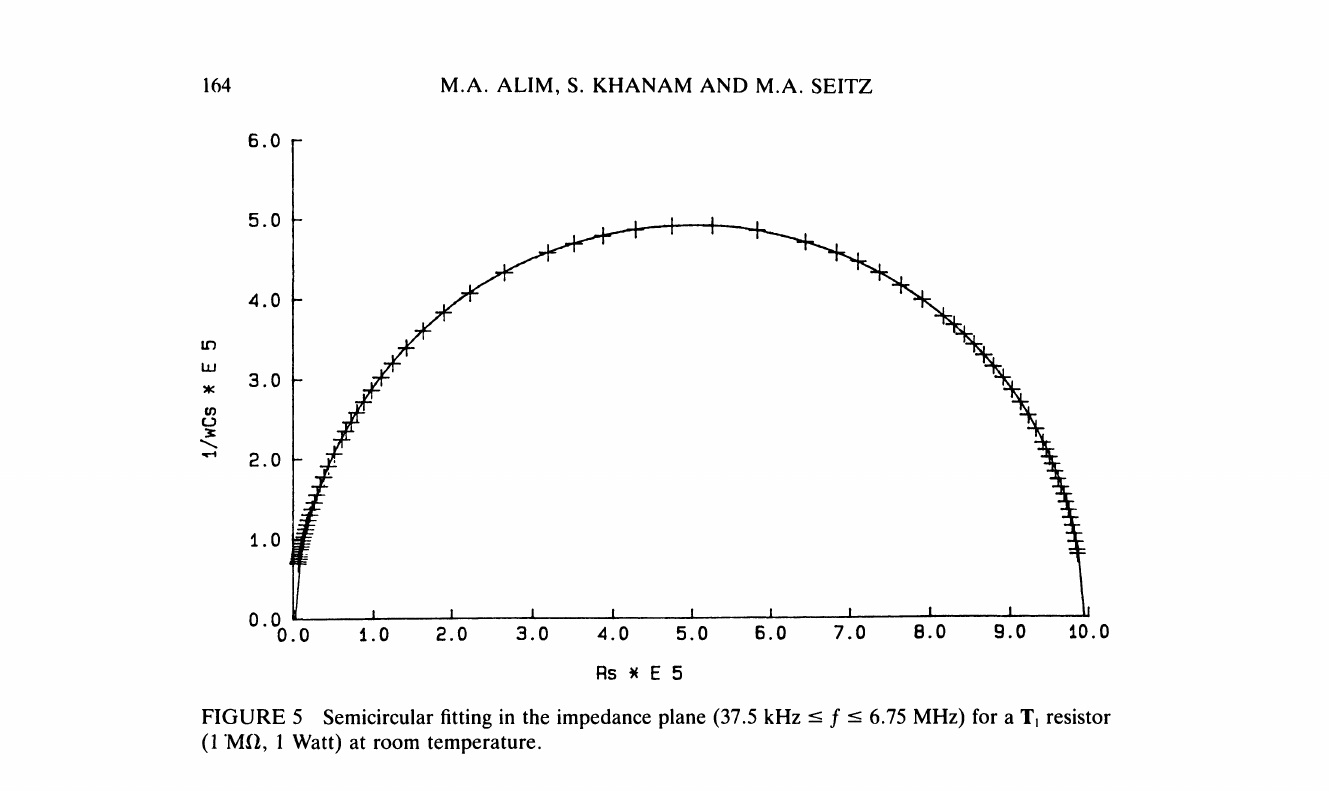
FIGURE 5 Semicircular fitting in the impedance plane (37.5 kHz <- f -< 6.75 MHz) for a T, resistor (1 "MII, Watt) at room